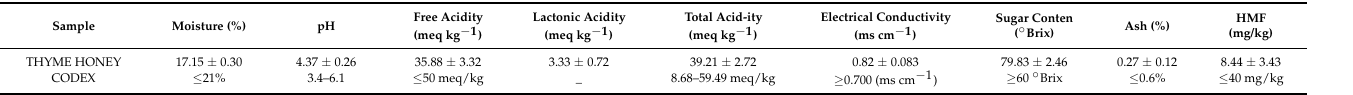
Table 1. Physicochemical characteristics of thyme honey